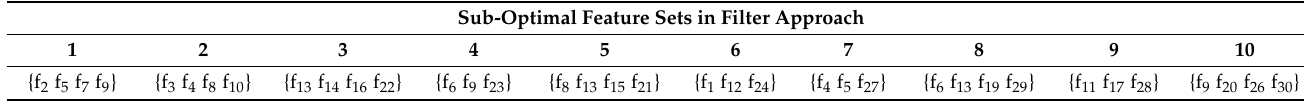
Table 5. Sub-optimal Feature Sets after Filter